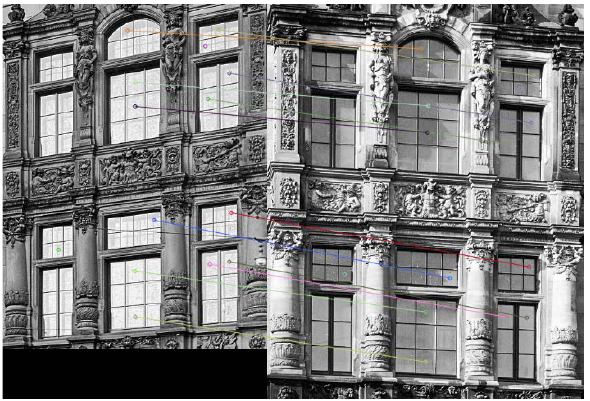
Figure 8. Matched point after calculation of fundamental matrix and filtering using RANSAC for